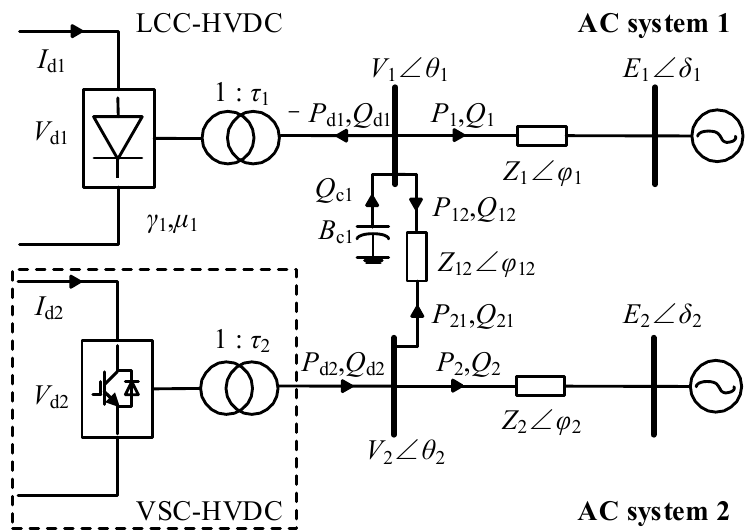
Figure 1. Hybrid dual-infeed HVDC system model .